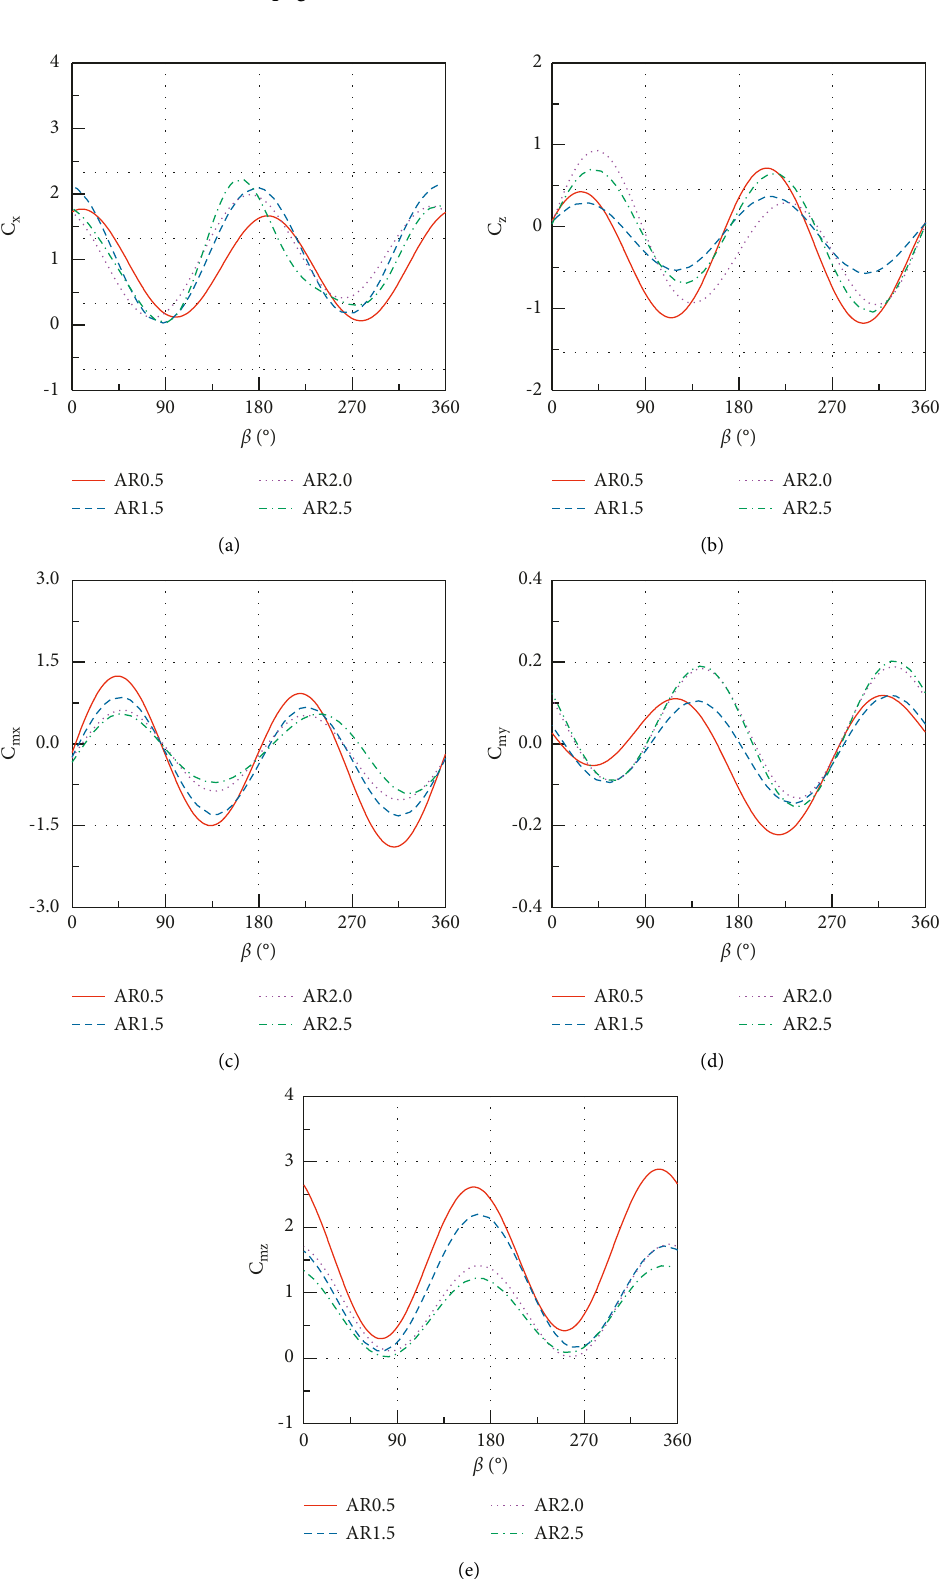
x – β , (b) C z – β , (c) C mx – β , (d) C my – β , and (e) C mz – β